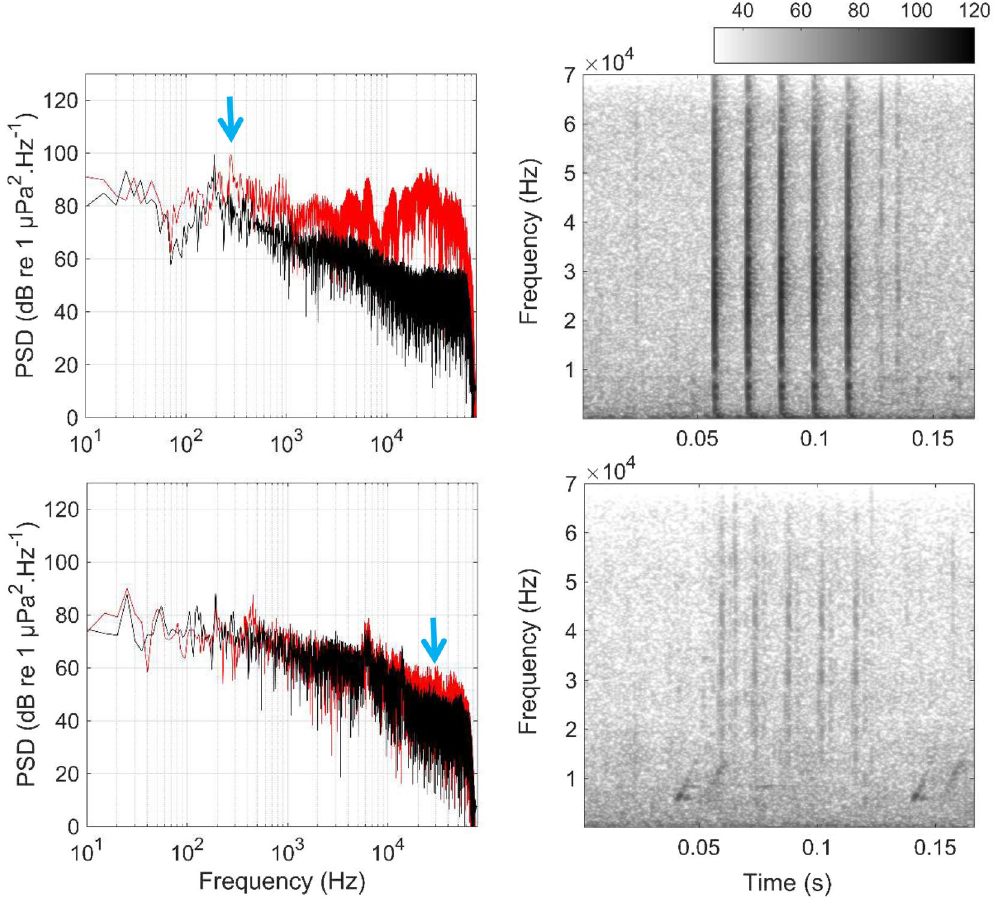
Figure 4. Power spectral densities (PSD, left) and spectrograms (right) of an antennal rasp produced by a large spiny lobster (carapace length = 13 cm) at 1 m (top) and 100 m (bottom). The black lines are the ambient noise recorded at the same distances. The blue arrows show the dominant frequencies of the recorded antennal rasp, calculated at 0.3 kHz at 1 m while it was calculated at 30 kHz at 100 m. The color scale bar is in dB re 1 µ Pa 2 .Hz − 1